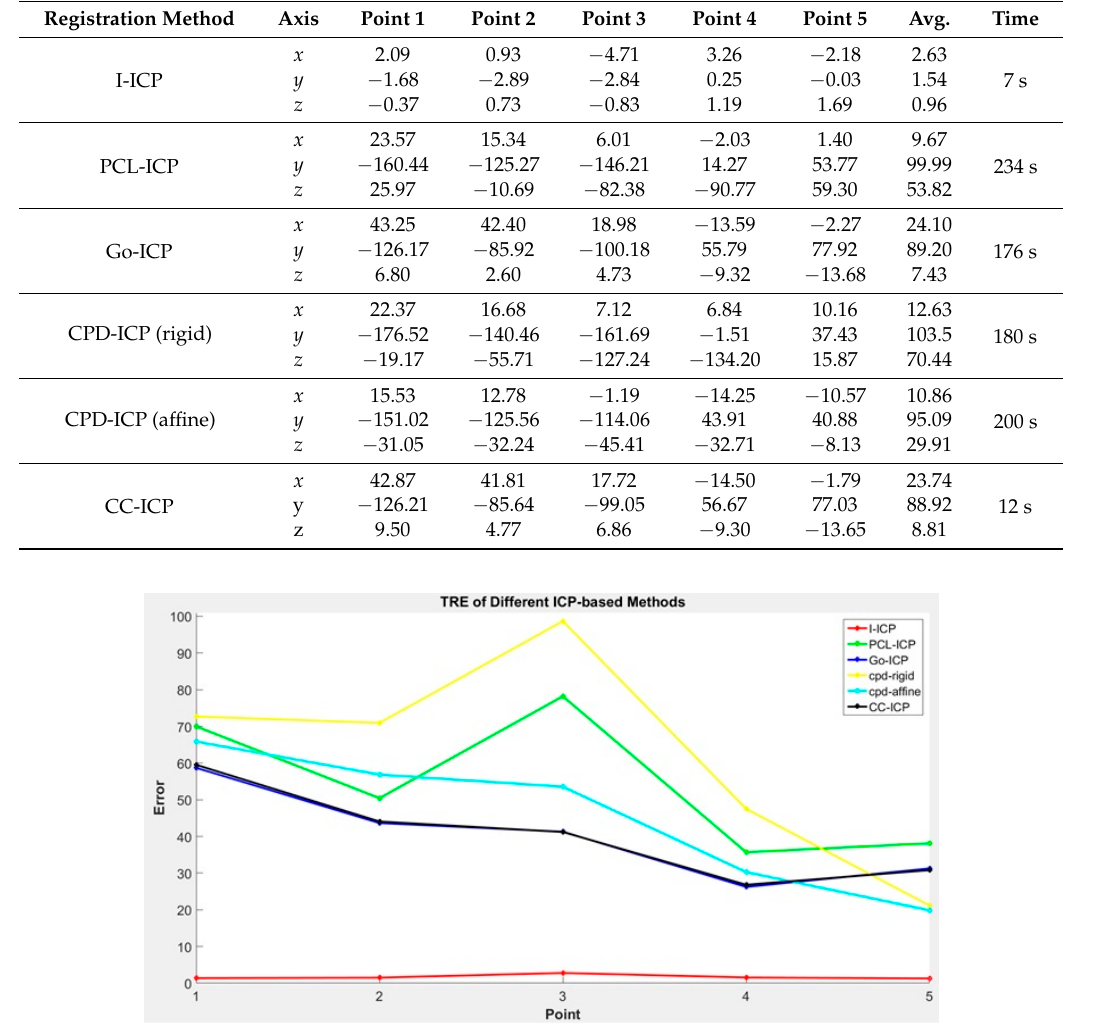
Figure 12. Comparison of the TREs for different ICP methods.